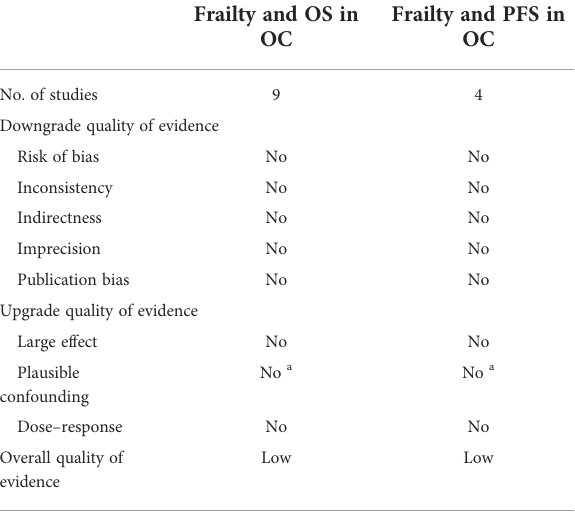
TABLE 4 Certainty of evidence by GRADE